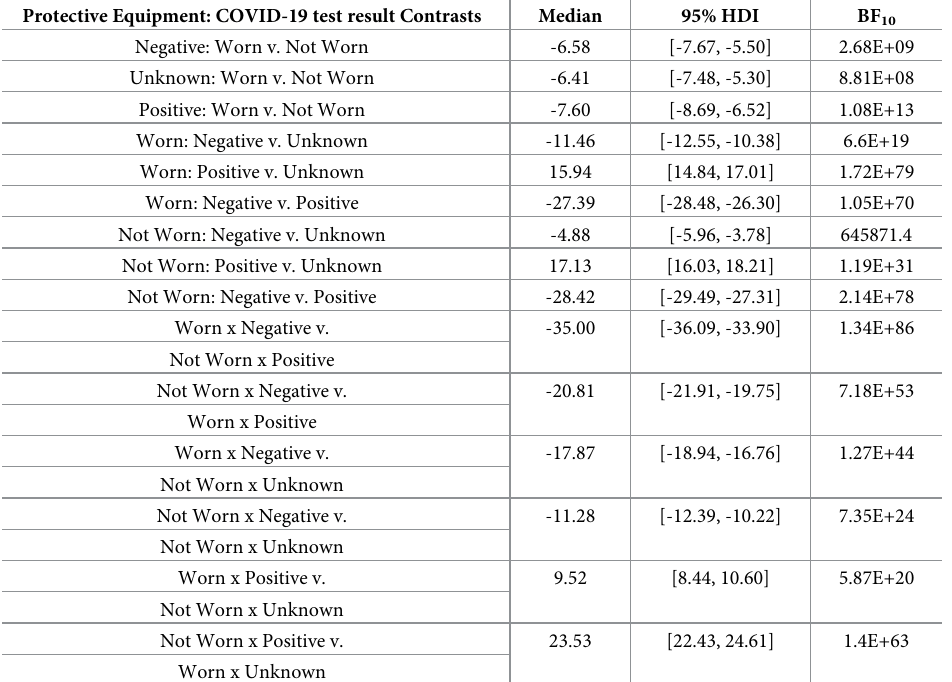
Table 5. Contrasts between all levels of protective equipment and COVID-19 test result. Protective Equipment: COVID-19 test result